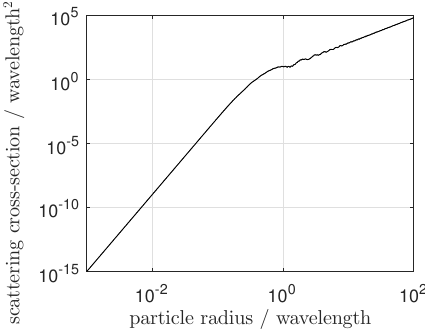
Figure 1. Calculated scattering cross-section over the particle radius normalized by the wavelength for a spherical particle made of diethylhexyl sebacate (DEHS) with a refractive index of 1.45 at